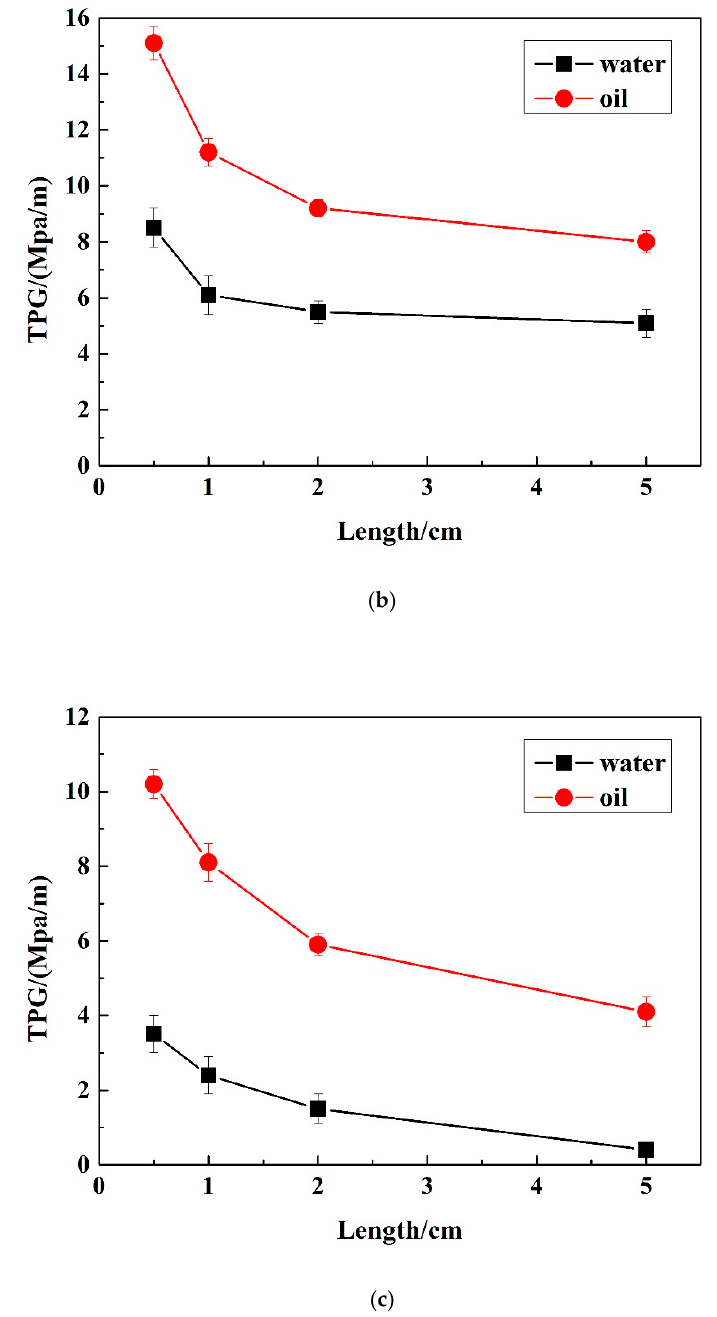
Figure 5. The TPG versus fluid type in cores with permeability of ( a ) 1.03 mD, ( b ) 8.16 mD, and ( c ) 29 mD.